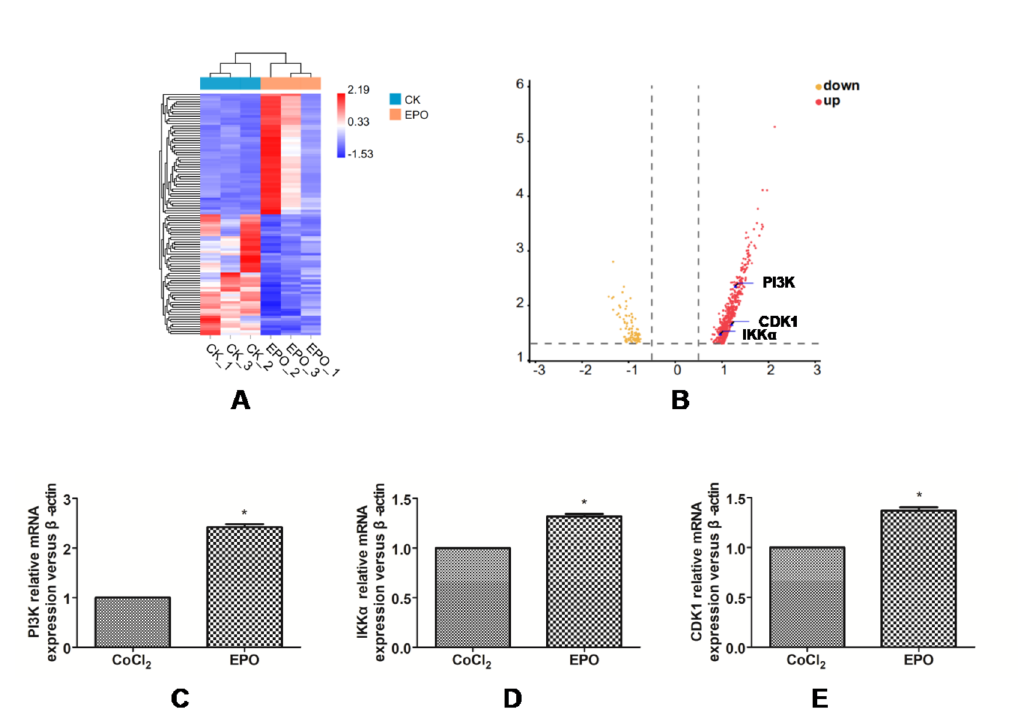
Figure 2 – The effect of EPO on cell transcriptome under hypoxia by high throughput sequencing. (A) The heat map,50 genes of up-regulation and 50 genes of down-regulation were selected for visualization, and the genes were sorted according to p value significance. (B) The volcano plot is mapped according to log2FC>0.5 , p<0.05, marking three target genes. ( C-E) mRNA transcription levels of PIK3, IKKα and CDK1 were verified by qPCR group, method. * P<0.05 vs. the CoC1 2